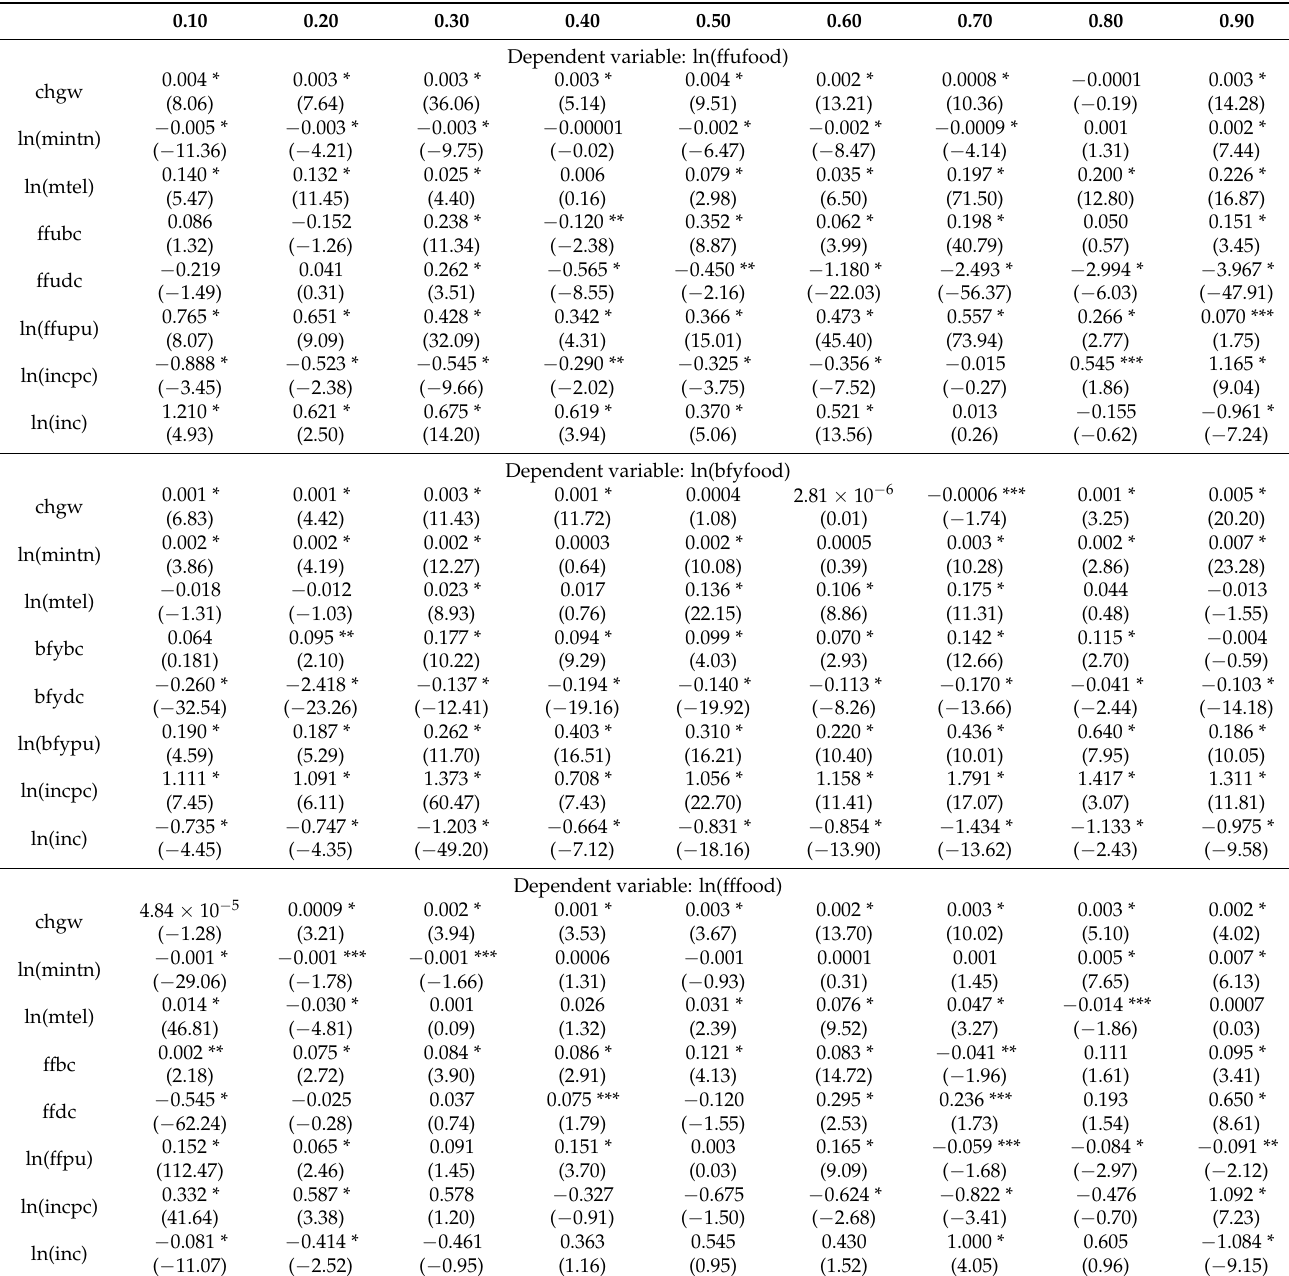
Table 5. Effects of trends, digital technology, and market concentration on each type of health and wellness food